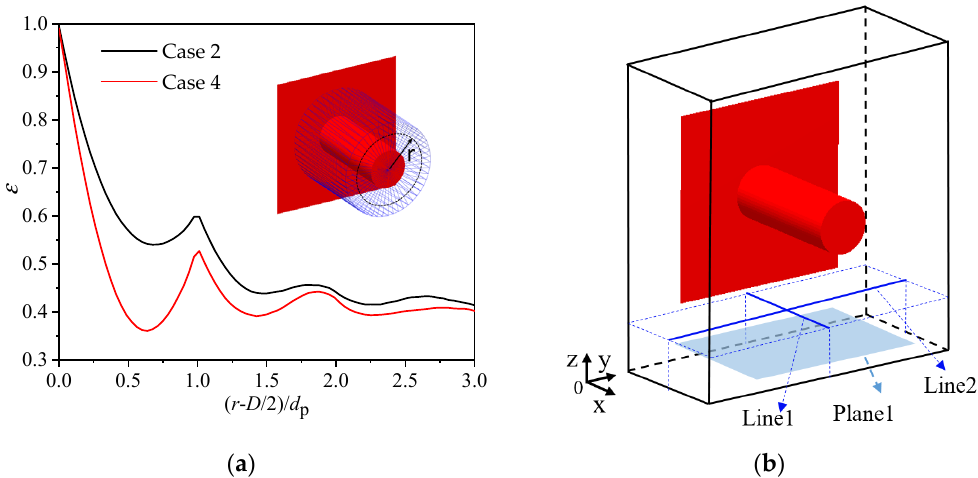
Figure 6. ( a ) Time-averaged porosity outside pin-fin; and ( b ) schematic diagram of Plane 1 and Lines 1 and 2. The particle temperature distributions at Lines 1 and 2 of t = 41 s are shown in Figure 7. The position of Line 1 is at y = 10 mm and z = 3 mm in the channel. The position of Line 2 is at x = 5 mm and z = 3 mm in the channel, as shown in Figure 6b. Compared with the smooth plate (Case 1), the plate with pin-fin (Case 2) enables particles far away from the plate to exchange heat with the pin-fin, and the temperature of particles at Lines 1 and 2 is significantly lower, as shown in Figure 7a. Compared with the static PFPU (Case 2), the oscillation along the Y direction (Case 4) increases the temperature diffusion of the particle flow around the pin-fin, as shown in Figure 7b.